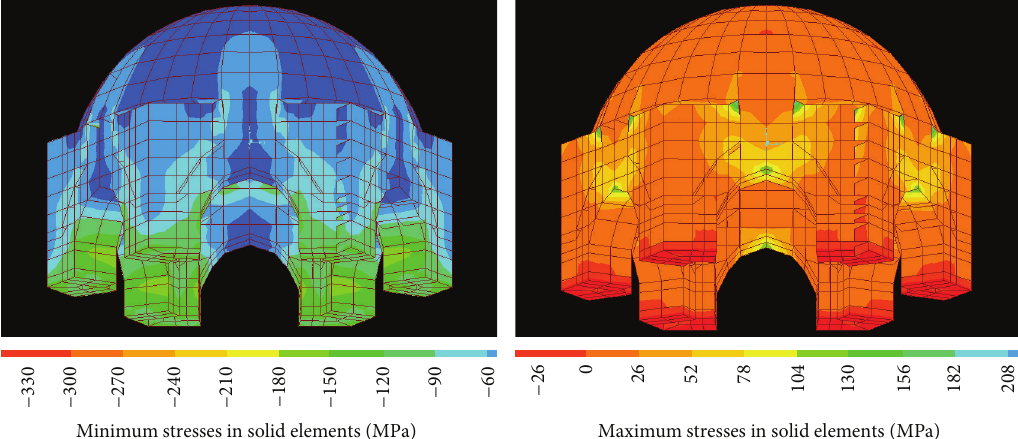
Figure 6: Stress contours in the dome of the tomb.